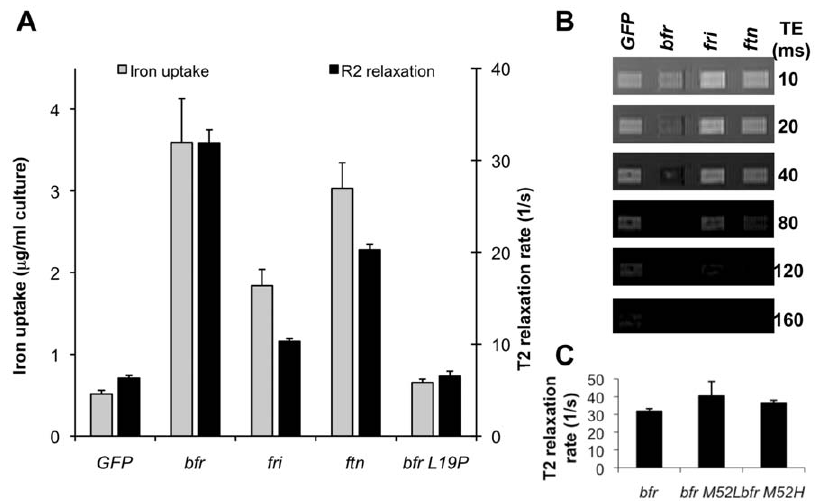
Figure 2. Effects of ferritin-like proteins on iron uptake and R2 relaxation. A ) Iron uptake and the effects on R2 relaxation were determined. Data represent mean (n=3) plus standard deviation of one representative experiment. Expression of Bfr resulted in the highest iron uptake and the most obvious effects on R2 relaxation. B ) Bacterial suspensions were put into wells of agarose-gels and images were obtained using a TR of 4000 ms with varying TEs to determine the R2 relaxation values in A ). C ) Expression of non-heme containing Bfr did not result in decreased R2 relaxation (p . 0.05).